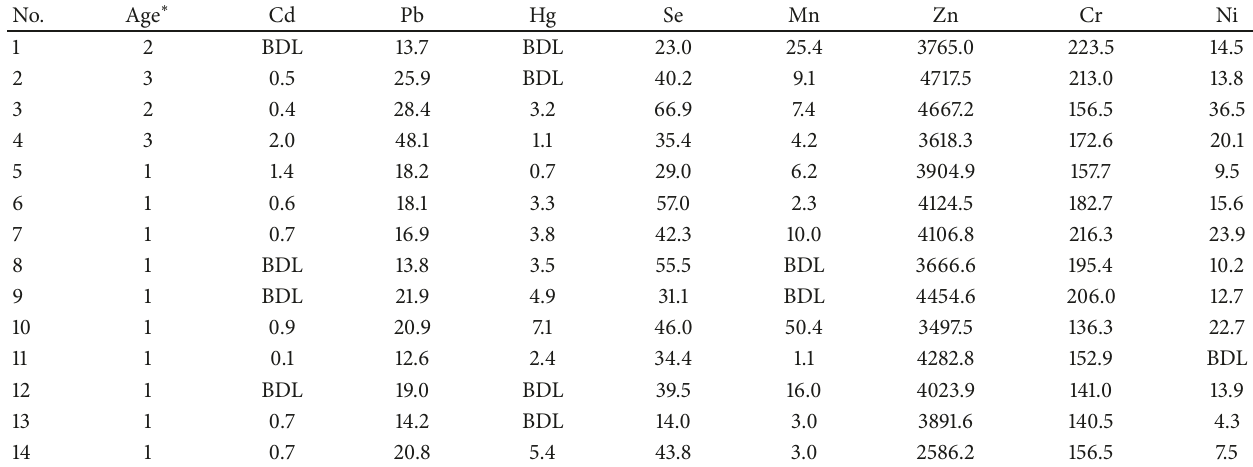
Table 1: Toxic elements levels in nonsmokers human blood ( 𝜇 g/L).